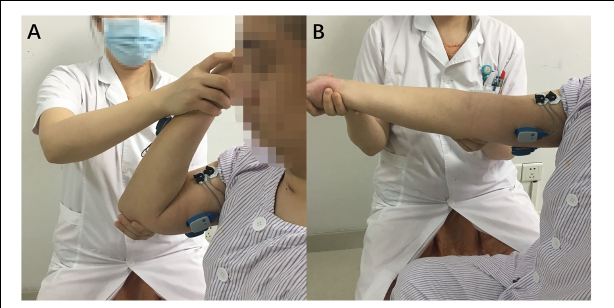
FIGURE 2 | The start (A) and maximum (B) positions of spasticity assessment passive